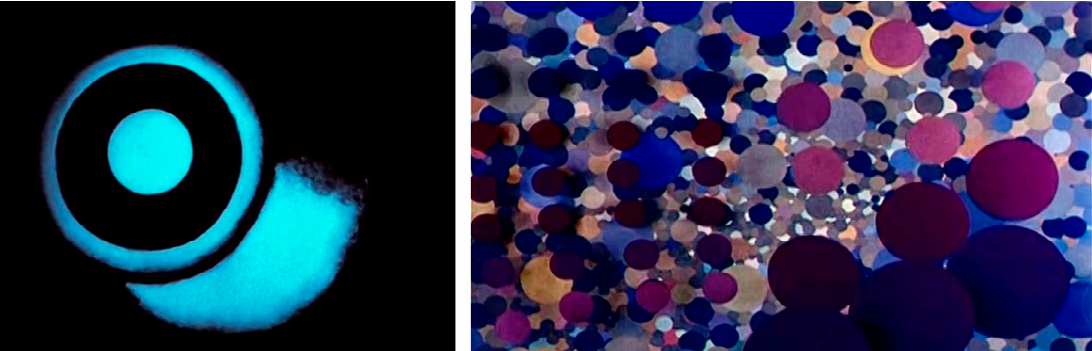
Figure 7. On the left , W. Ruttmann, frame retrieved from the short film Lichtspiel I, 1921; on the right , O. Fischinger, frame retrieved from the short film An Optical Poem,